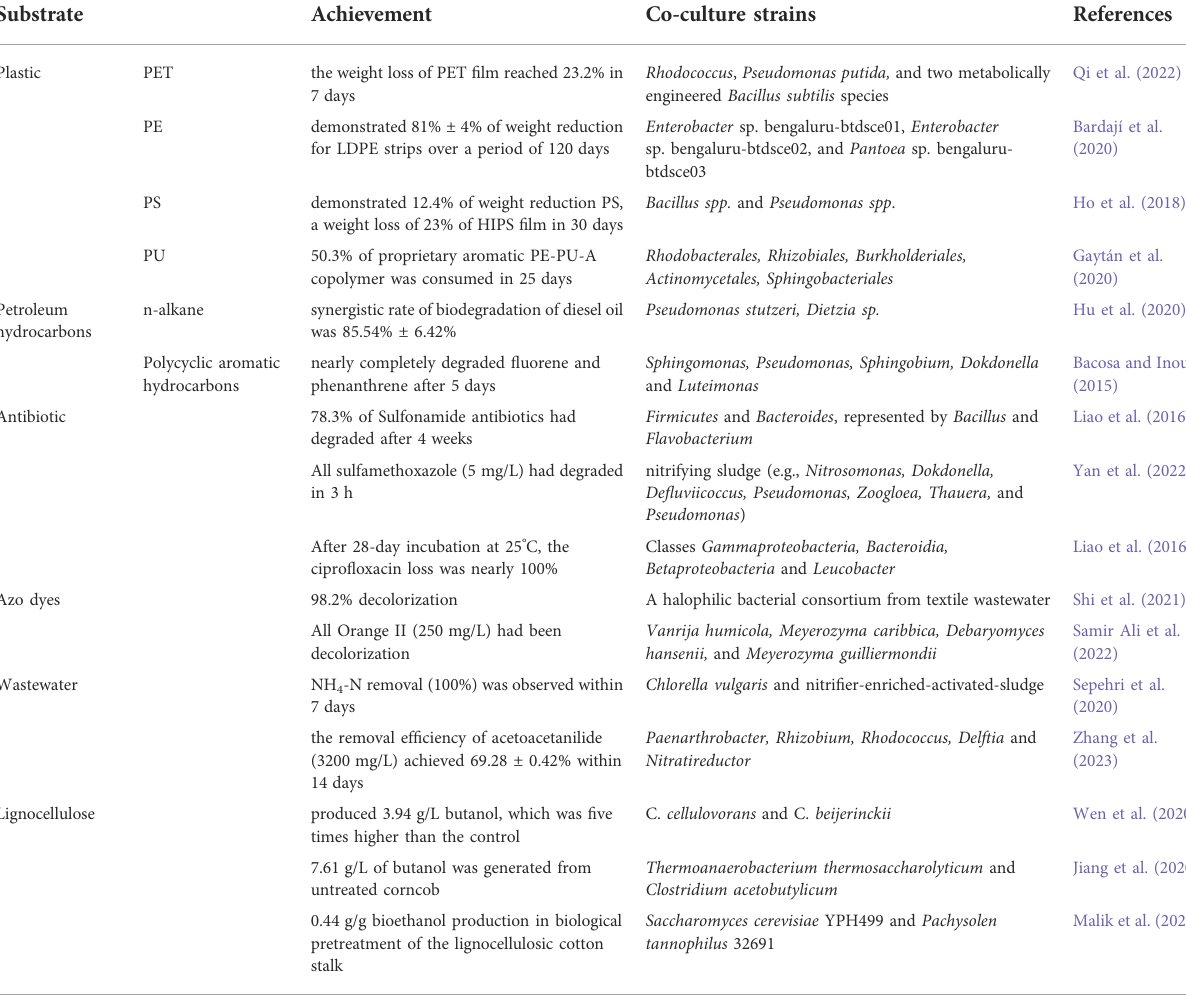
TABLE 1 An overview of recent advances in the degradation of complex compounds by microbial consortia.